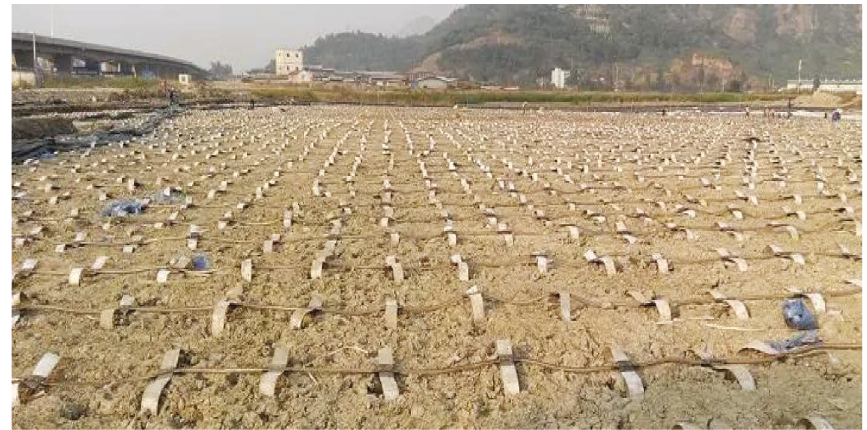
Figure 5: Construction